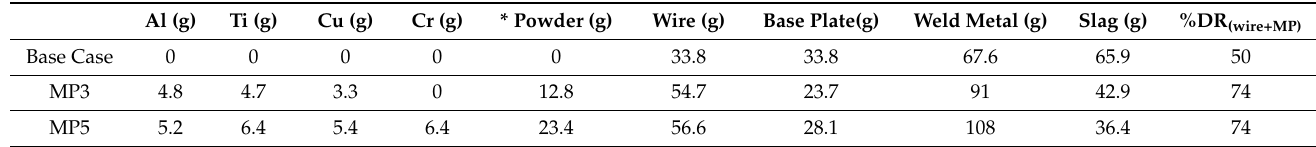
Table 5. Post-weld masses and metal powder mass added to weld